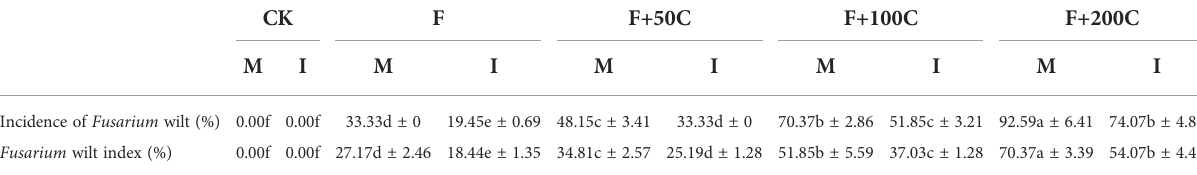
The data represent the mean ± standard error of three biological replicates. Different letters for each index indicate signi fi cant differences at p < 0.05 (Tukey ’ s test). F, Fusarium oxysporum f. sp. fabae